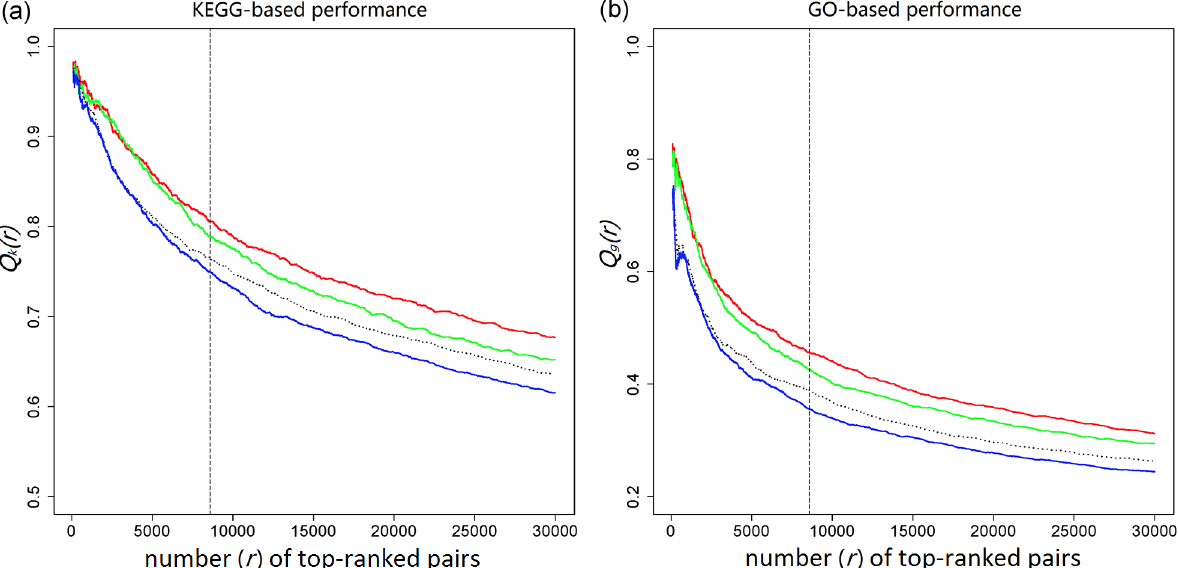
Fig 3. Comparison of the performance between P , P S and P SI . In both plots, x -axes are the number ( r ) of top-ranked protein pairs (ranked by their probabilities: P , P S and P SI ); y -axes are the KEGG ( a ) and the GO ( b ) annotation overlap rates – Q k ( r ) and Q g ( r ) for the top-ranked r protein pairs. Line colors represent the three formulas: green for (1), blue for (2) and red for (3). Dotted black lines (between green and blue lines) represent formula (2) with direct links integrated (with λ = 2). Vertical dashed lines ( r = 8,583) represent the cut-off for significantly associated protein pairs. Fig.3 is based on the top-ranked 30,000 protein pairs from the three lists (each consists of over 1.5 million protein